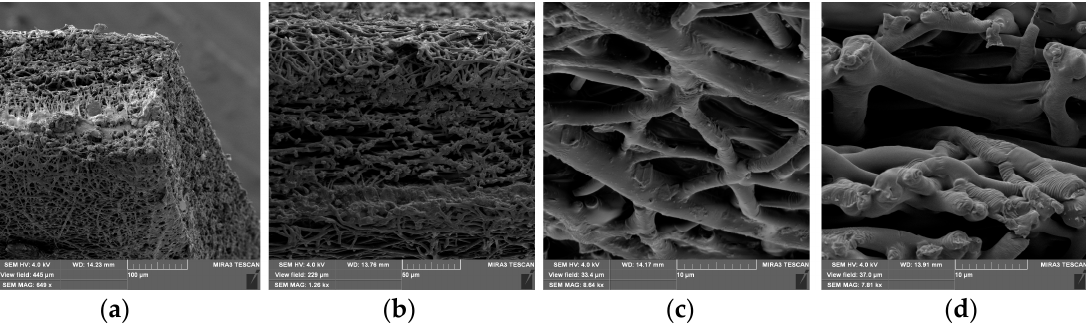
Figure 1. SEM images of drug loaded 24 wt.% 50:50 PLGA nanofibers (PLGA 2 ).Images of same PLGA mat with different scale bars 100 µm (a), 50 µm (b), 10 µm (c) and 10 µm (d).